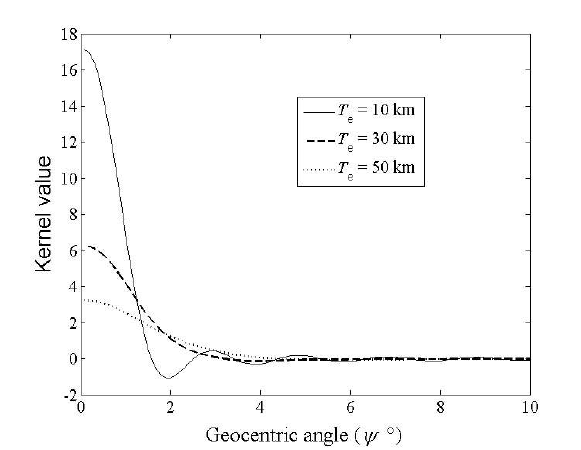
Figure 2: Kernel of convolution integral for different elastic thick- nesses and T 0 = 33